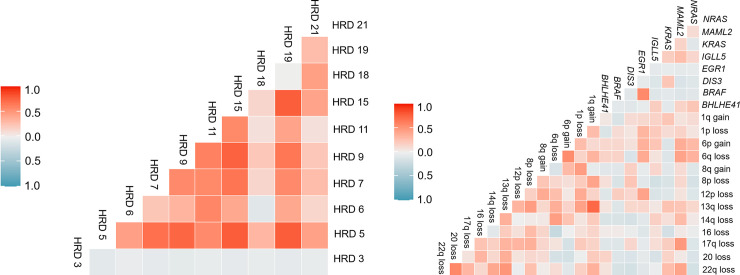
Pairwise associations between mutations and copy number variations.(A) In patients with hyperdiploid multiple myeloma, chromosome 5 variations were correlated with variations in chromosomes 9, 15, and 19, while chromosome 15 variations were correlated with variations in chromosomes 9 and 19. (B) Among patients without hyperdiploid multiple myeloma, 1q gain was correlated with 13q loss, BRAF mutation was correlated with EGR1 mutation, and MAML2 mutation was correlated with 17q loss.